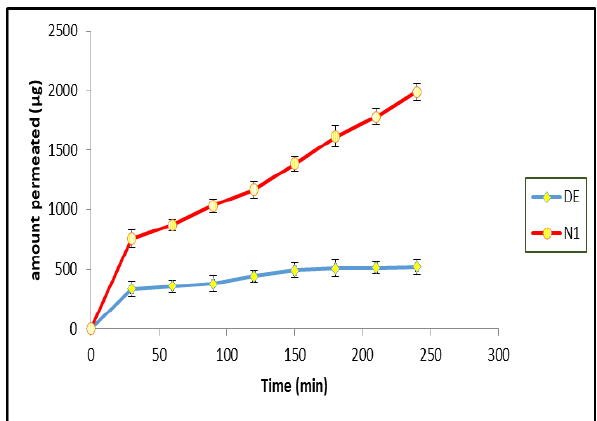
Figure 5. Permeation of dabigatran etexilate from optimized formula N1 and pure drug suspension through non-everted rat ileum, values of mean ±SD